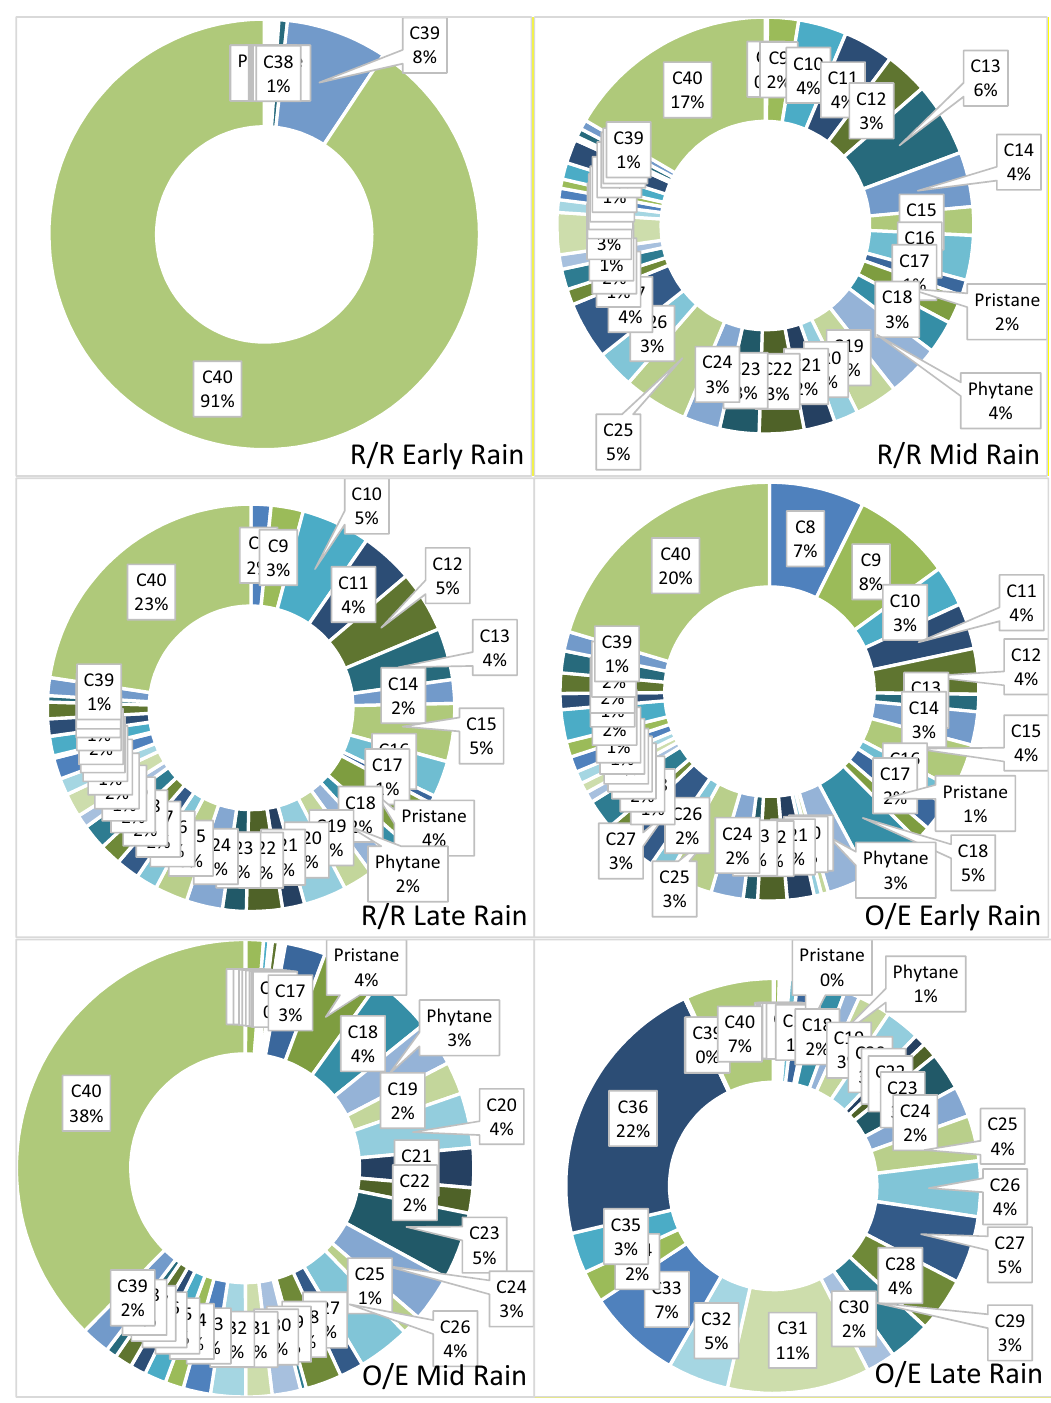
Figure 1. Percentage composition of TPHs across sampling period. R/R Rumuodomaya/Rumuodome, Obio- Akpor LGA; O/E Ogale, Eleme